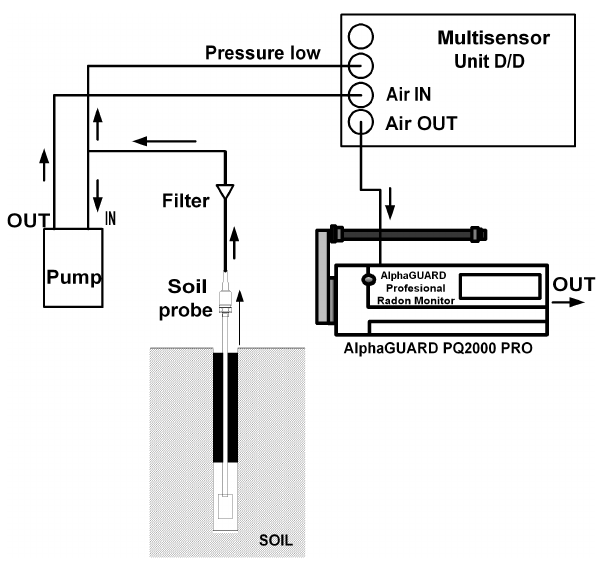
Fig. 5. Soil permeability measurement (Genitron Manual Multisen- sor